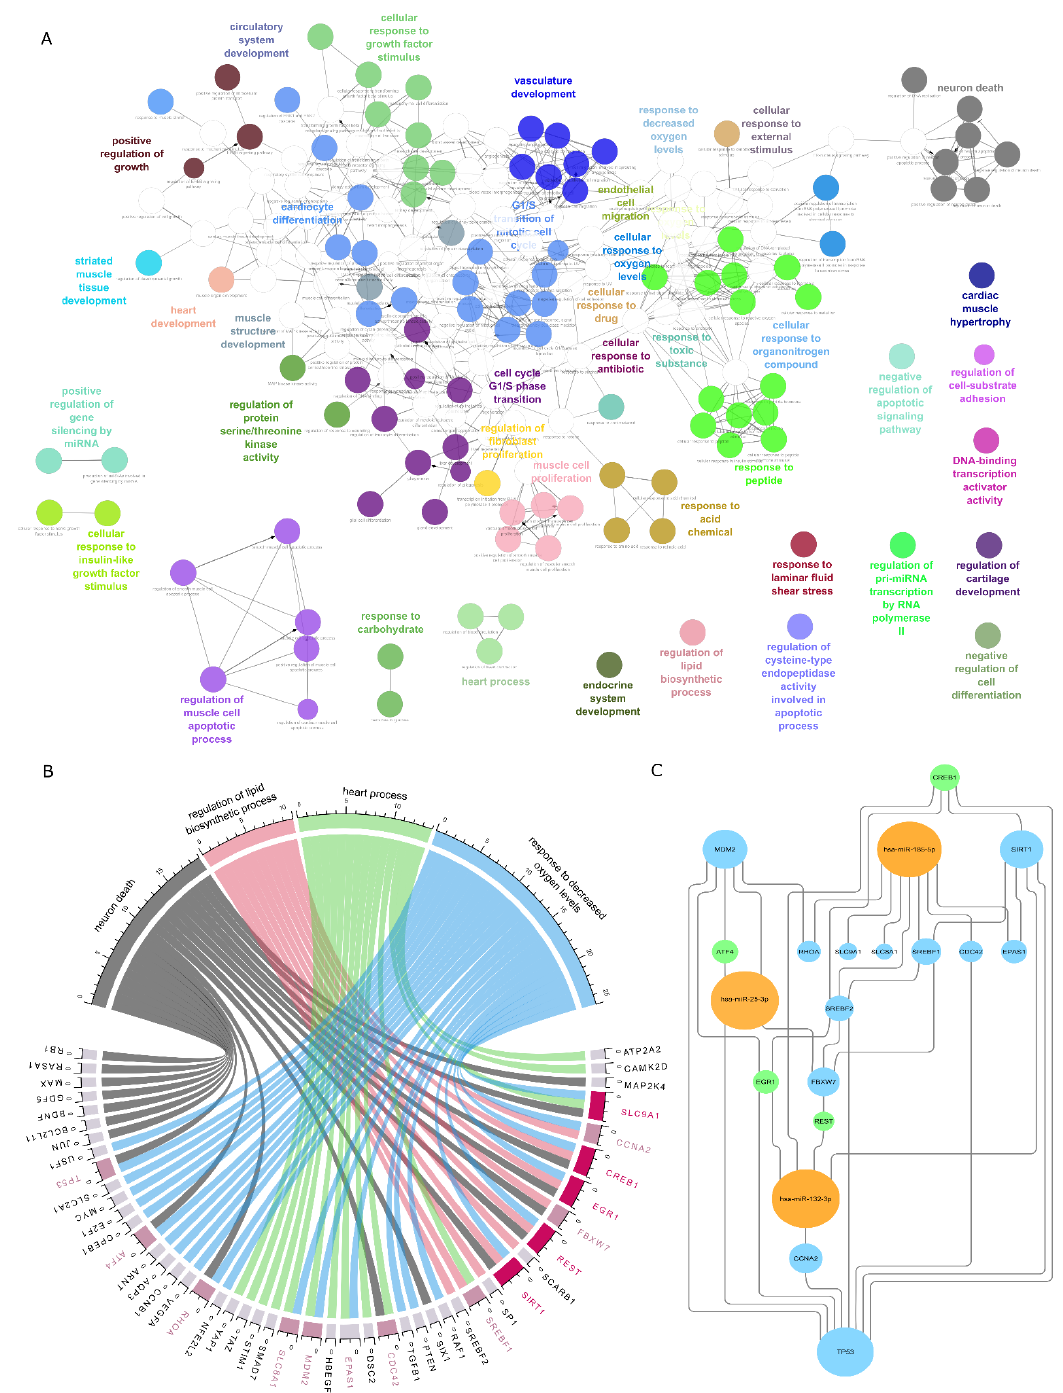
Figure 4. Functional analysis and regulatory module identification. ClueGO functional analysis based on the previous gene miRNA transcription factor network. Functionally related terms are grouped and visualized in the same color. Term similarity is indicated by node proximity ( A ). GO terms associated with phenotypes exhibited in FGR, “neuron death”, “regulation of lipid biosynthetic process”, “heart process”, and “response to decreased oxygen levels” including genes falling into these terms were used to filter the original regulatory network ( B ). Genes falling into more than one GO term are highlighted (pink). The filtered original network revealed regulatory elements consisting of deregulated miRNAs (orange), highly connected target genes (blue), and transcription factors (green), important for the manifestation of FGR phenotypes ( C